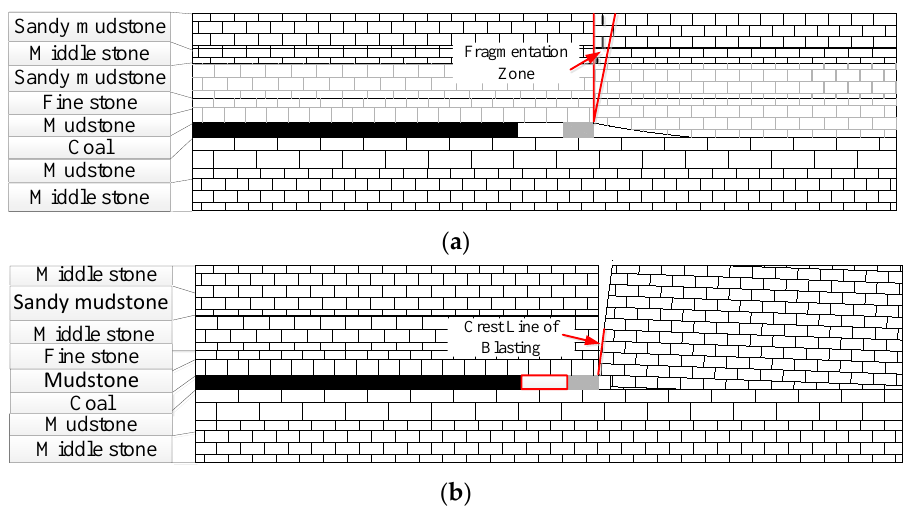
Figure 4. The behaviors of overlying roof strata with and without shallow-hole blasting. ( a ) Roadway retained surrounding rock structure when roof is not cut; ( b ) roadway retained surrounding rock structure after roof